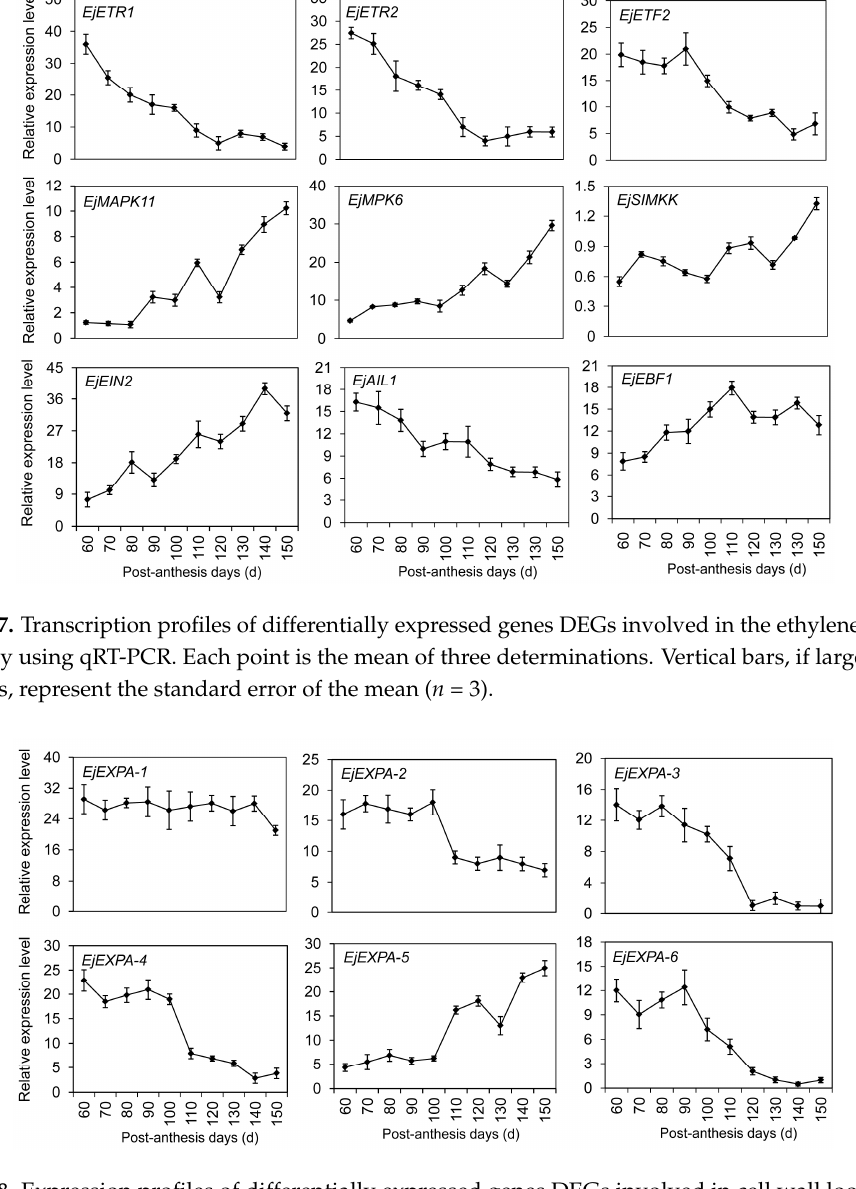
Figure 8. Expression profiles of differentially expressed genes DEGs involved in cell wall loosening and enlargement using qRT-PCR. Each point is the mean of three determinations. Vertical bars, if larger than symbols, represent the standard error of the mean ( n = 3).